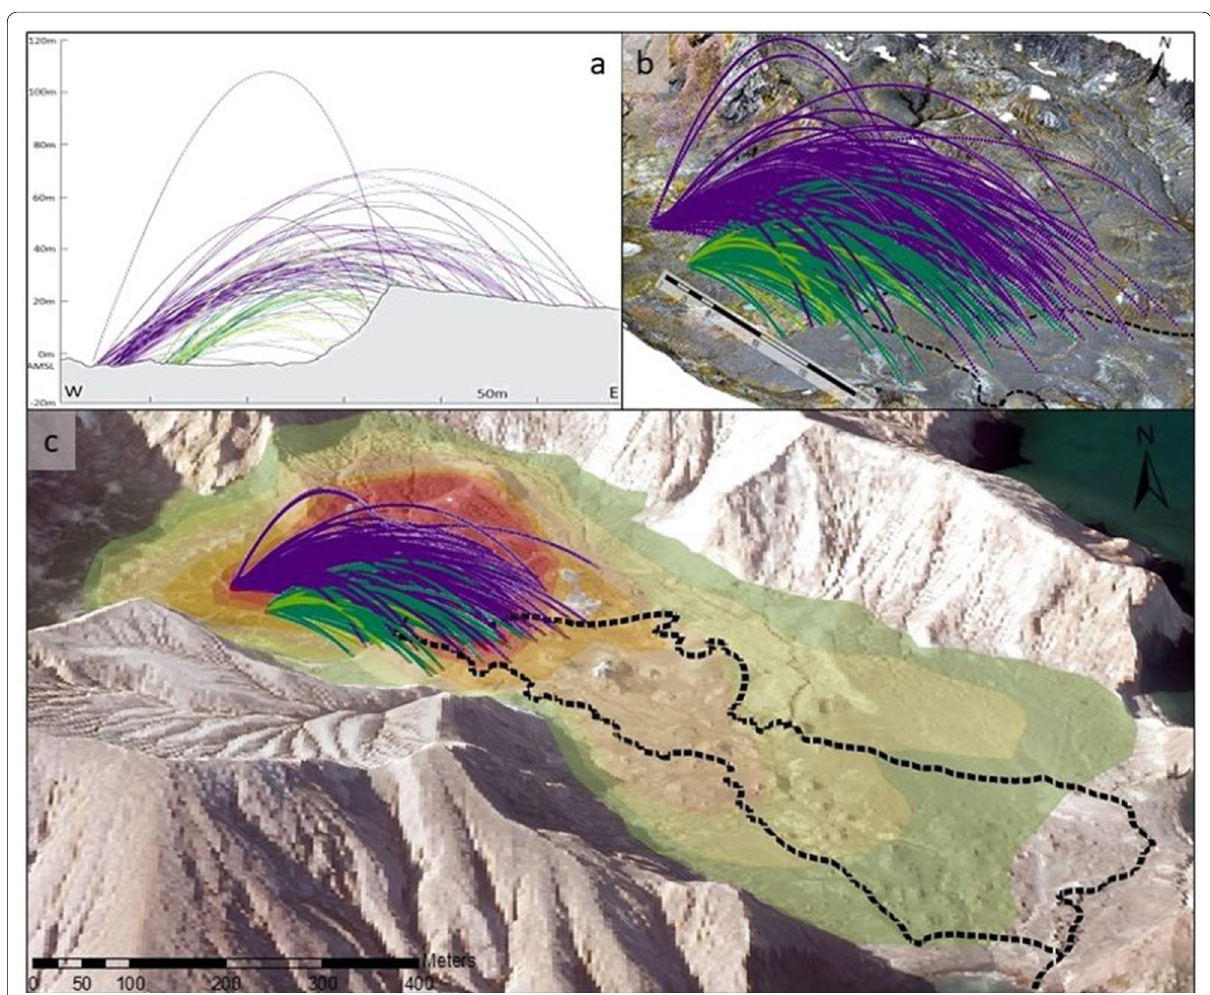
Fig. 15 Particle trajectory and its use in determining the hazard footprint of the eruption. Pulse 6 trajectories are dark purple, dark green trajectories represent Pulse 5, and light green Pulse 4. The number of particles shown have been reduced for figure clarity, number remains proportional to that modelled. a 2D trajectory figure showing 50 particles for Pulse 6, 23 for Pulse 5, 10 for Pulse 4. Created by Dale Cusack b 3D ballistic trajectories, 100 particles P6, 46 for Pulse 5, 20 for Pulse 4. Created in ArcScene. c The ballistic trajectories overlain with surge isopachs and tourist